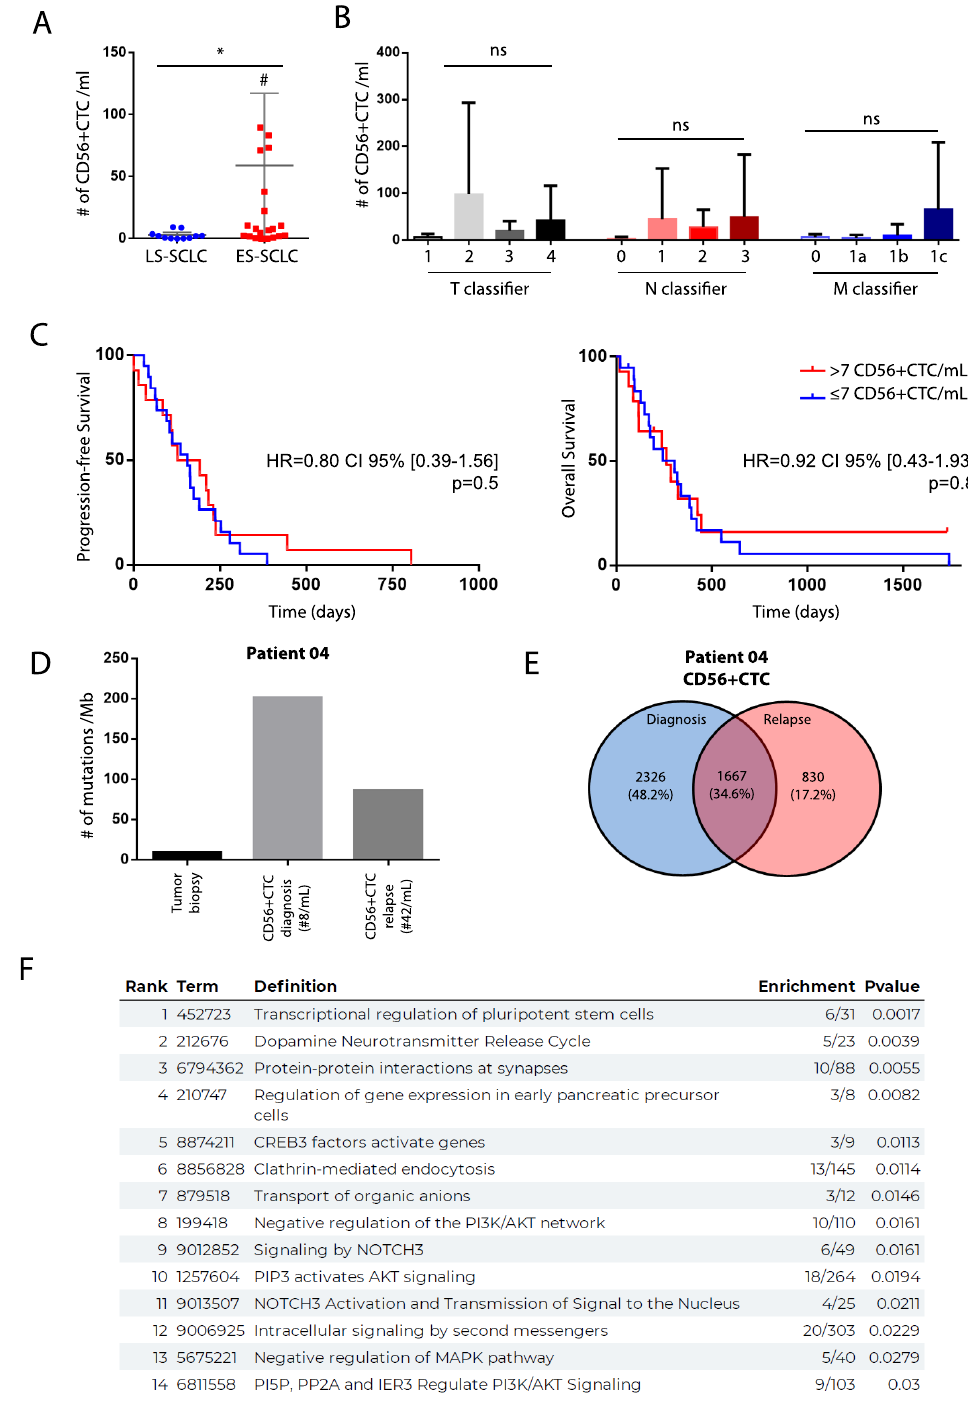
Figure 3. Clinical significance of CD56+ CTC at diagnosis and somatic evolution of CTC at relapse. ( A ) Diagnosis numeration of CD56+ CTC according to SCLC staging (*: p < 0.05; # : two values outside the limits of the graph). (B ) Numeration of CD56+ CTC according to the 8th TNM IASCL classification (ns : non- significant) ( C ) Kaplan–Meier curve of progression-free-survival (left panel) or overall survival (right panel) according to the numeration of CD56+ CTC with a pre-specified cut-off value of 7 CTC/ml. ( D ) Mutational load of all samples from patient 04. ( E ) Venn diagrams representing non synonymous mutations (SNPs & InDels) in CTCs at diagnosis and after relapse (right) for patient 04. ( F ) Analysis of the REACTOME pathways of the common non synonymous genes (1667) at diagnosis and after